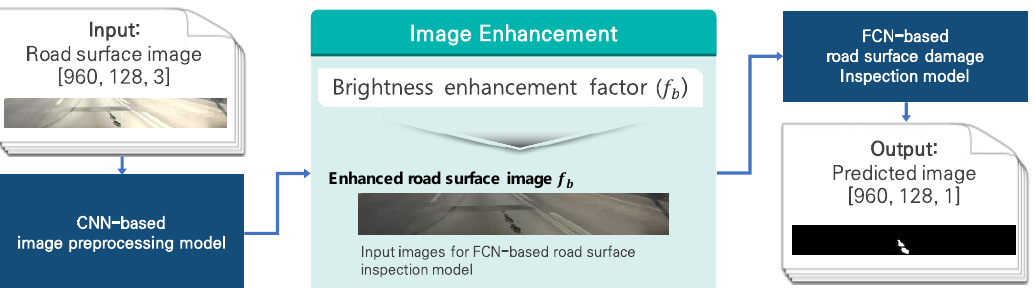
Figure 1. Overall flow of the developed road-surface inspection system.